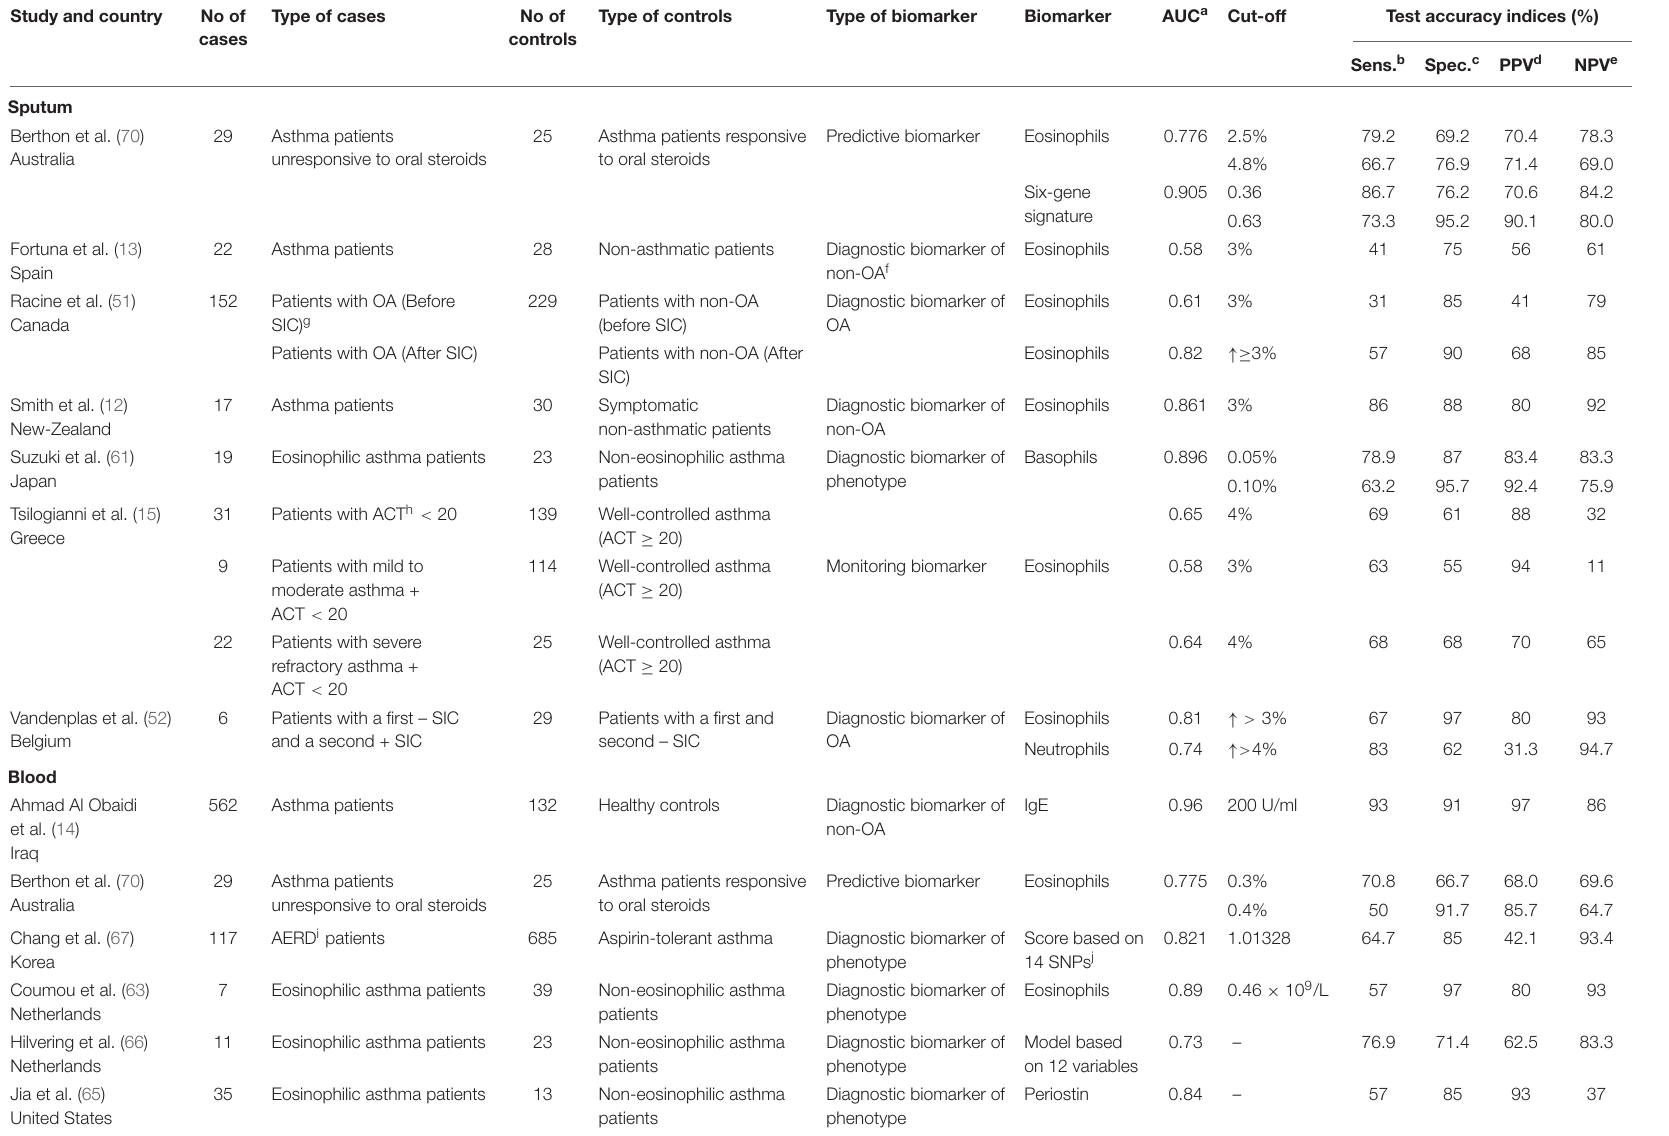
TABLE 2 | Diagnostic accuracies of liquid biomarkers for